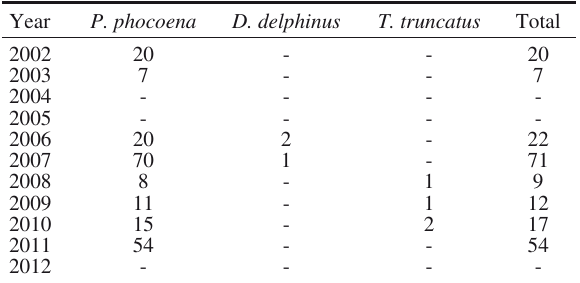
Table 5. – Structure of dolphin by-catches on the Romanian coast in 2002-2012